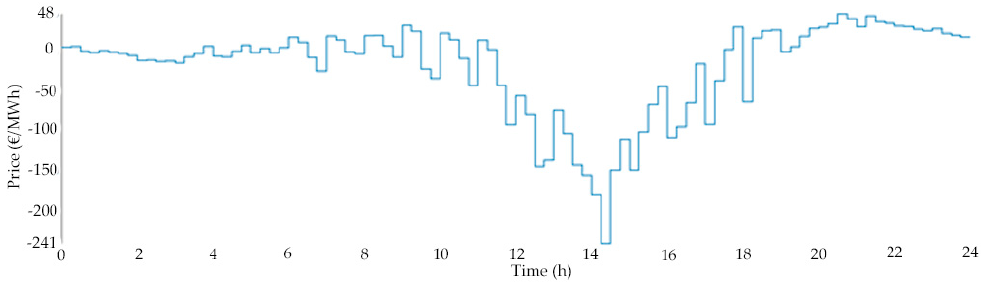
Figure 5. Volume weighted average price in the quarter-hours continuous intraday spot market on 8 May 2016 in Germany.